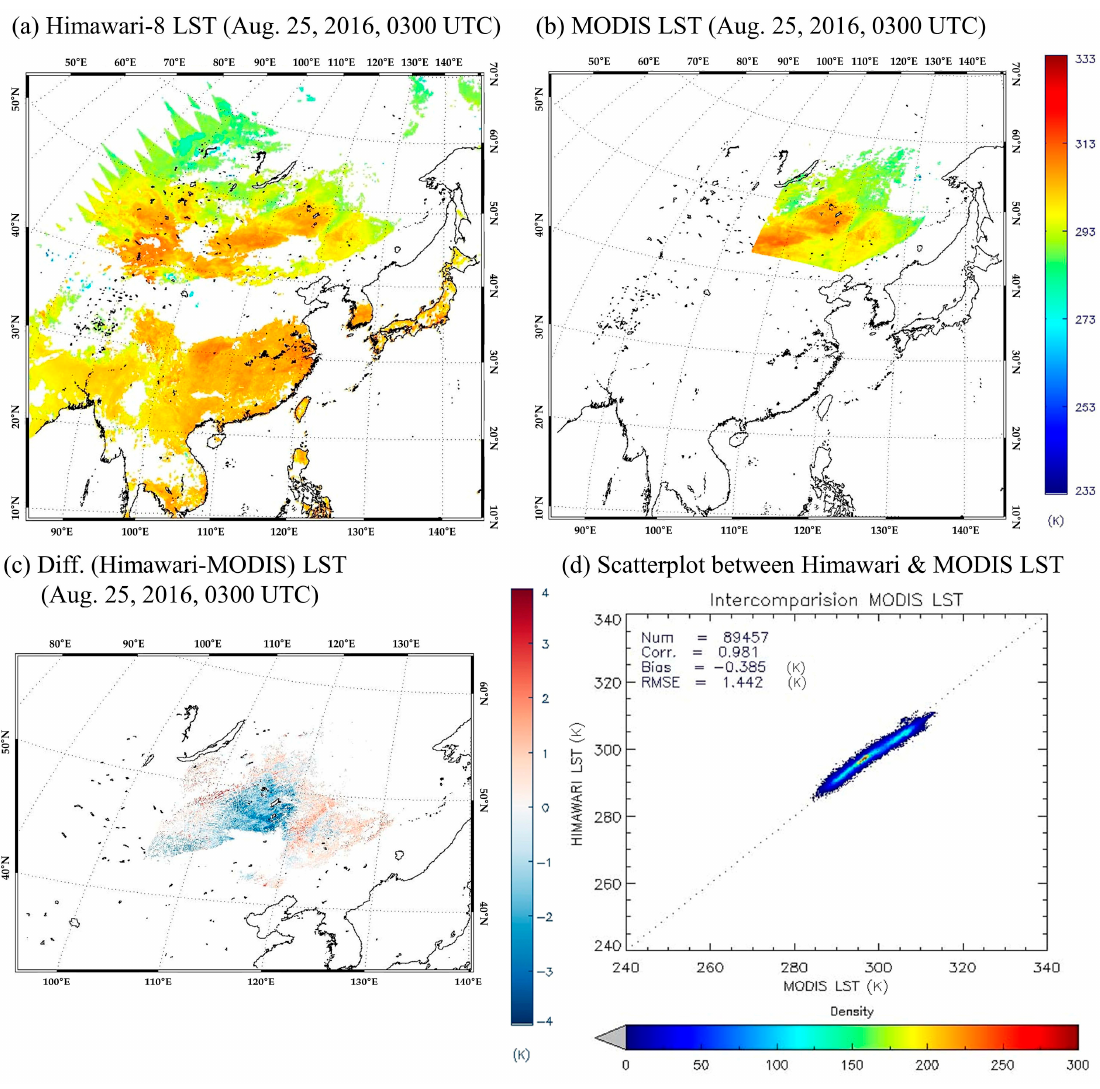
Figure 10. Same as Figure 7 except for August 25, 2016, 0300 UTC.